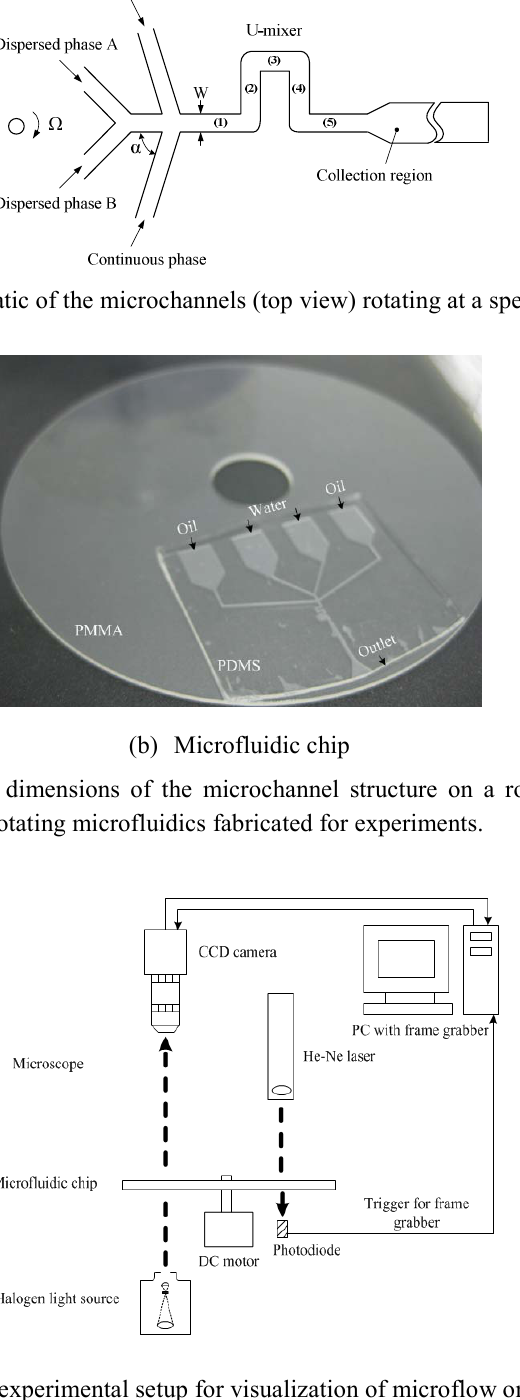
Fig. 2 Schematic of experimental setup for visualization of microflow on a rotating